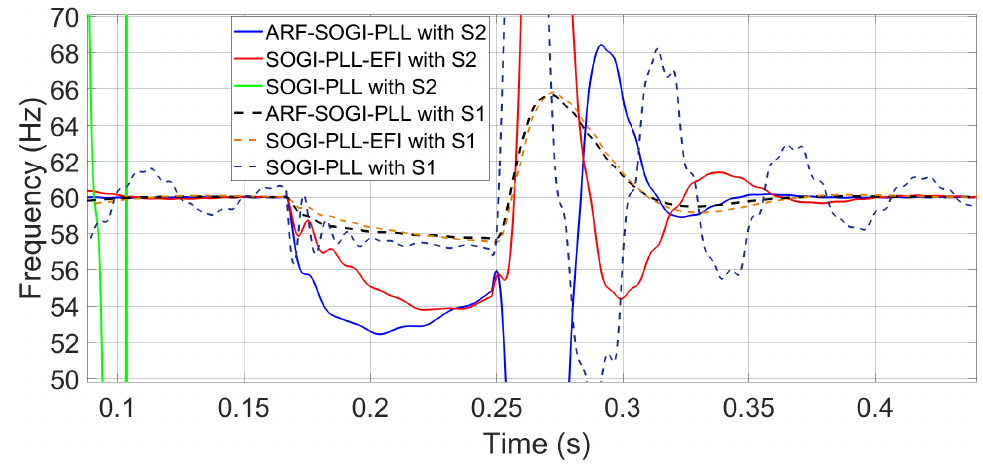
Figure 18. Frequency measured before, during, and after phase-to-ground short-circuit fault.